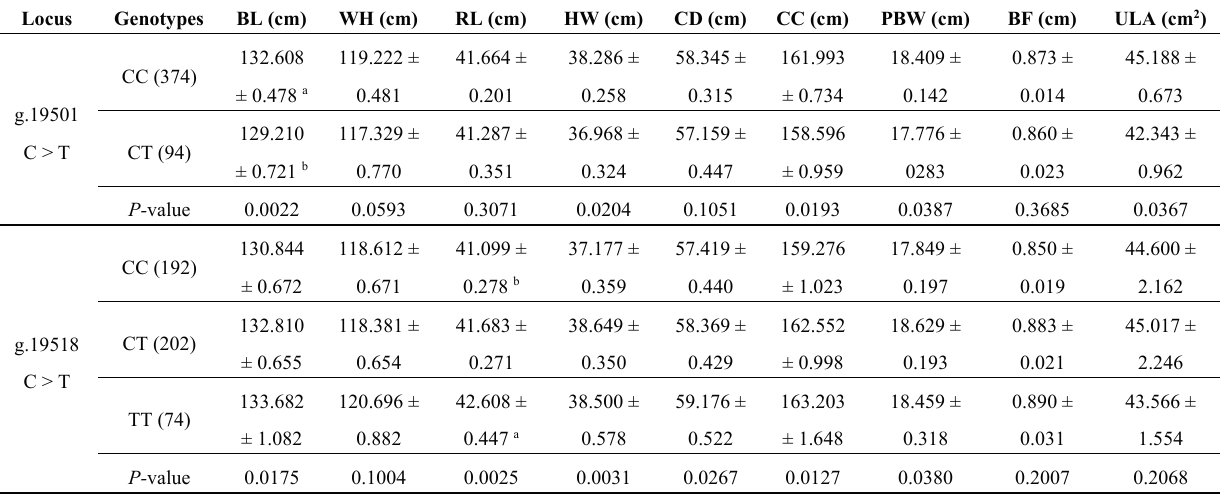
Table 3. Association of different genotypes of single nucleotide polymorphisms (SNPs) in SIRT2 with body size traits in Qinchuan cattle. Note: Values are shown as the least squares means ± standard error. a,b Means with different superscripts are significantly different ( p < 2.78 × 10 − 3 ) after Bonferroni correction. Body length (BL), withers height (WH),